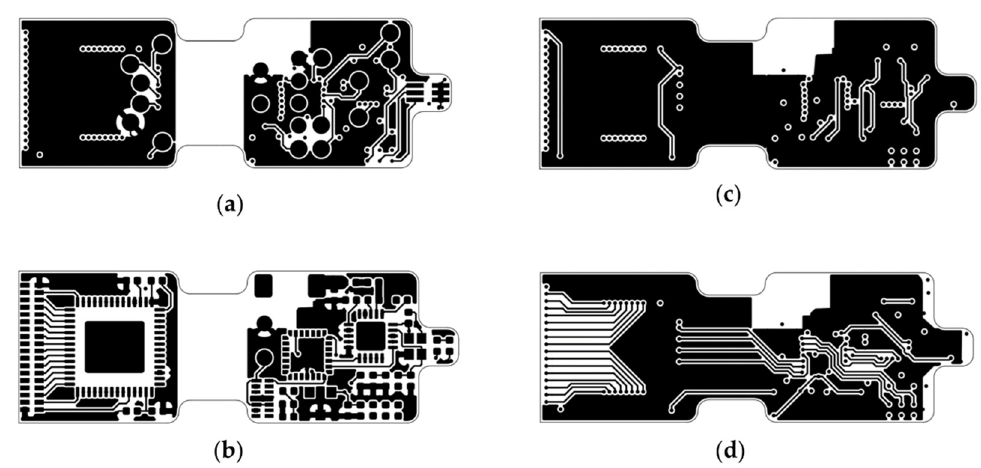
Figure A6. Base station PCBs: ( a ) Layer B_Cu, ( b ) Layer F_Cu, ( c ) Layer In1_Cu, ( d ) Layer In2_Cu.